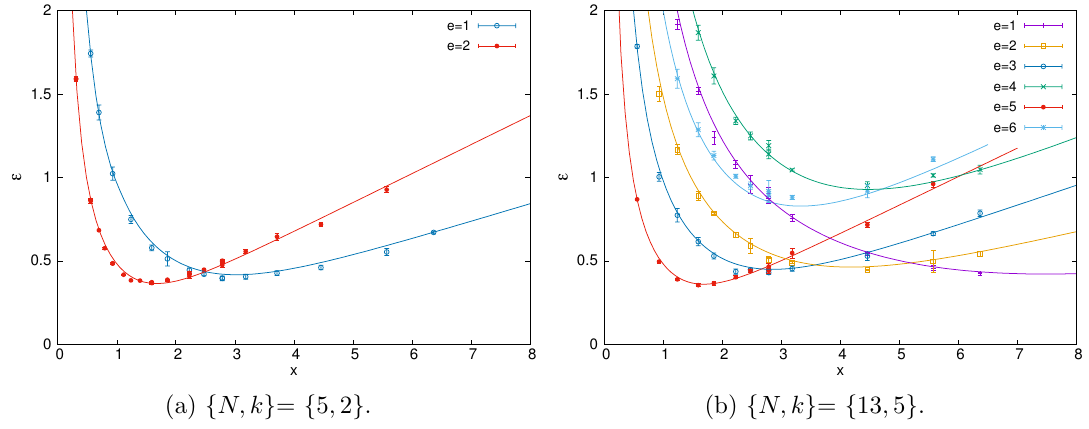
Figure 3. The x -dependence of the torelon energies for states with electric (cid:13)uxes ( e; 0), for the Fibonacci pairs f N; k g = f 5 ; 2 g and f 13 ; 5 g . The continuous lines are determined as for (cid:12)gure